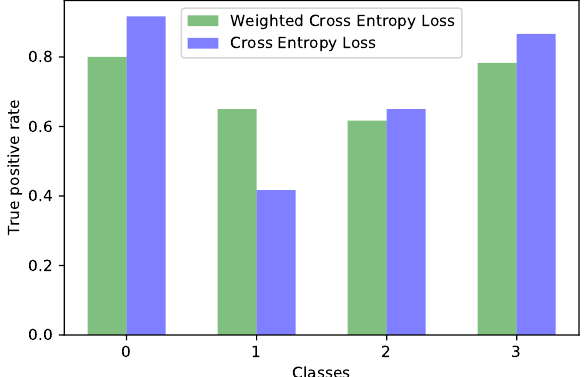
Figure 5. True positive rate comparison between the model trained with weighted cross entropy loss and simple cross entropy loss. Only images with acetic acid were used. The class weighting was recalculated in each epoch according to the model error (one minus true positive rate), and we applied a transformation φ ( x ) = exp ( 100 x ) . As can be observed, the model trained with class weighting provided better balanced true positive